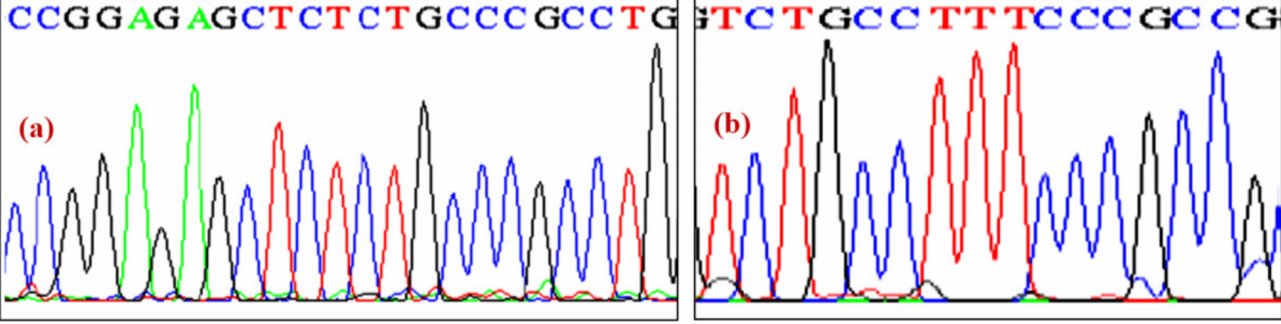
Figure 1. ( a , b ) The chromatogram of exon 1 and 2 of NKX2-5